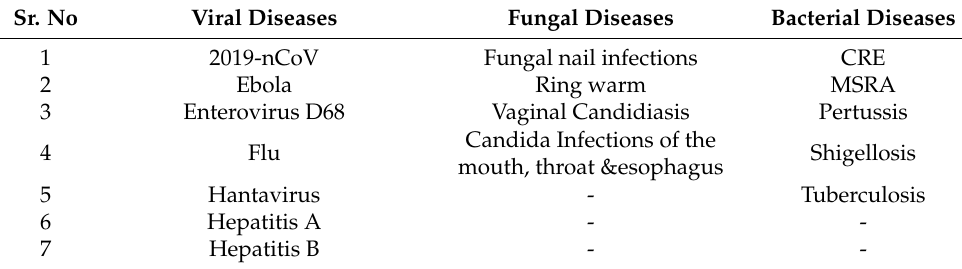
Table 1. List of communicable diseases spread with different pathogens. Sr. No Viral Diseases Fungal Diseases Bacterial